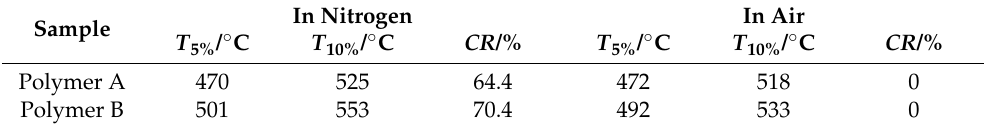
Table 3. Thermal performance parameters of the poly(BCPD) resins in nitrogen and air atmosphere. Sample